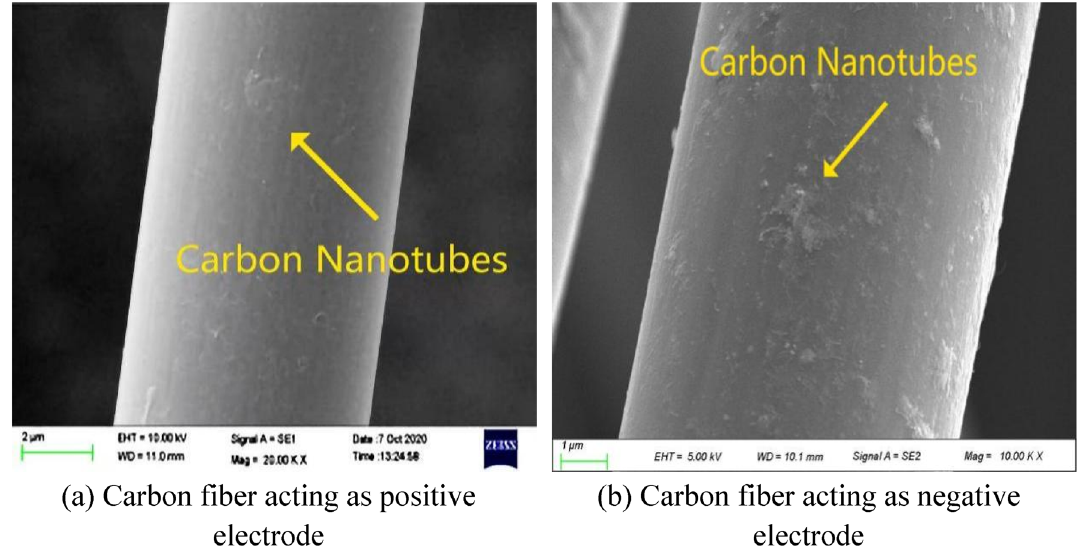
Figure 3. Micro pictures of MCNF using carbon fiber as positive electrode and negative electrode.